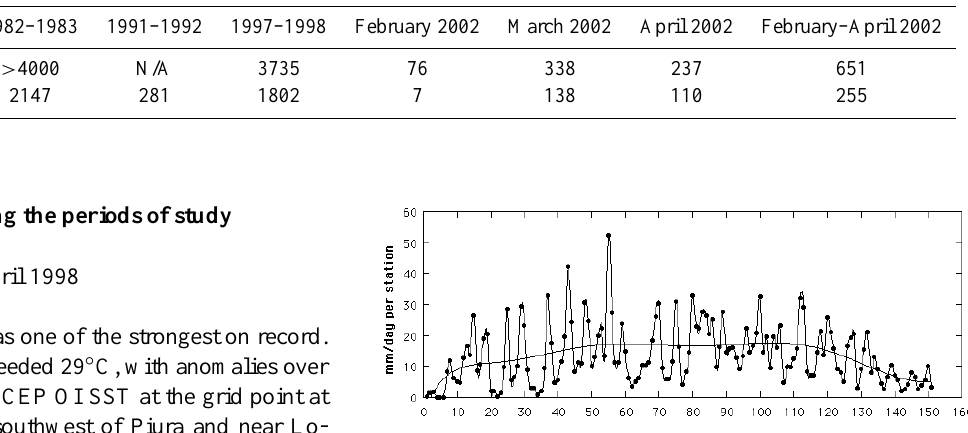
Table 1. Total rainy season rainfall in Piura and Chulucanas (mm) (Sources: PECHP, CORPAC, Ordinola et al., unpublished data 2 ; Goldberg et al., 1987).